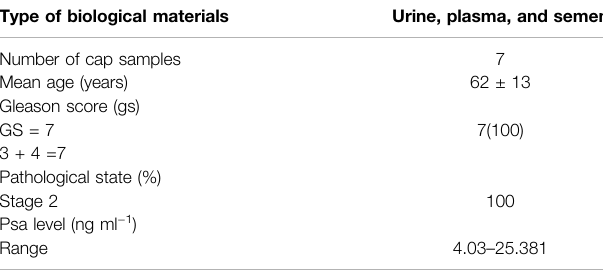
TABLE 1 | Clinical and pathological characteristics of the population. Type of biological